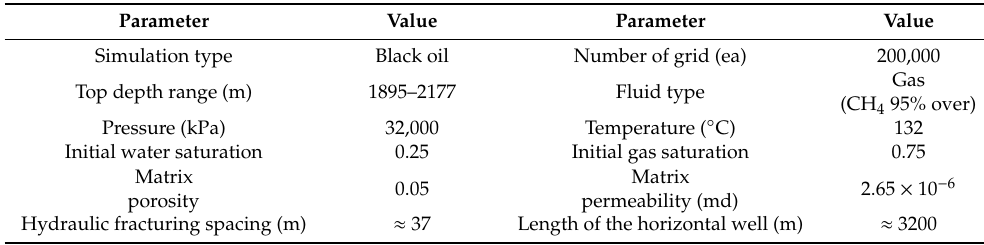
Table 1. Reservoir properties and model